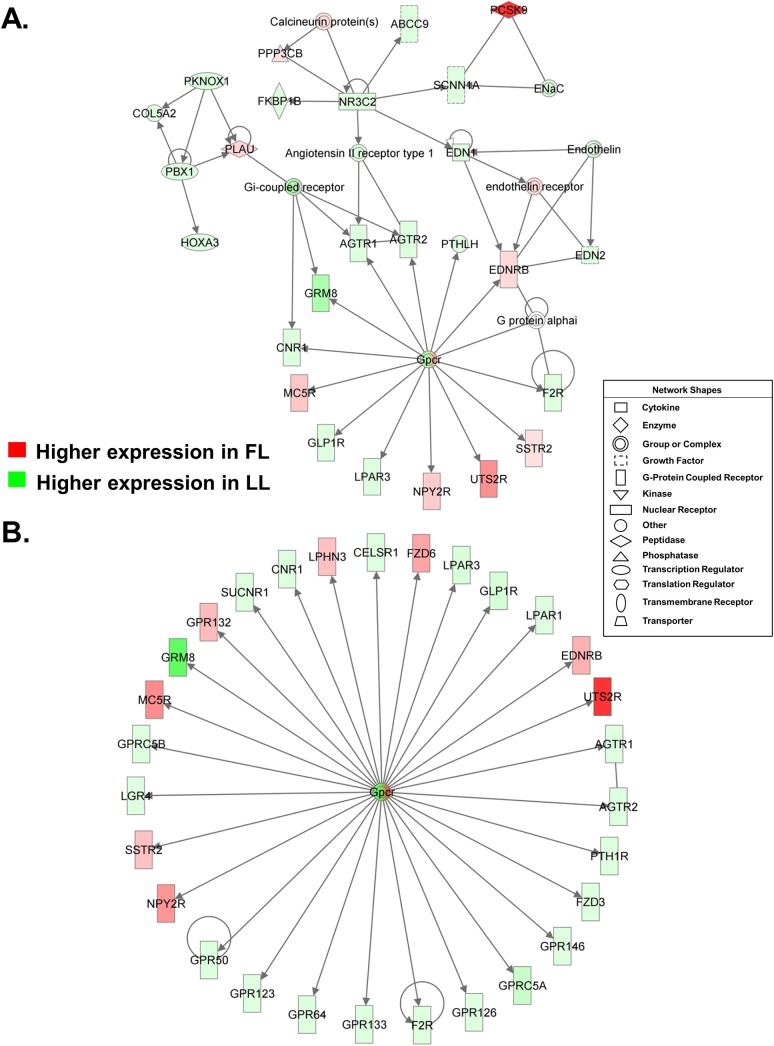
Differential expression of G-protein coupled receptors in abdominal fat of FL and LL chickens.(A) Gene interaction network of G-protein coupled receptors (GPCR), some of which interact with regulators of angiogenesis and blood pressure. Visceral adipose tissue shows an extensive over-representation of 29 GPCRs (B), where 21 DE genes are over-expressed in the LL and 8 DE genes are expressed higher in FL chickens. Many of these GPCRs could be considered as “ectopically expressed” in adipose tissue.